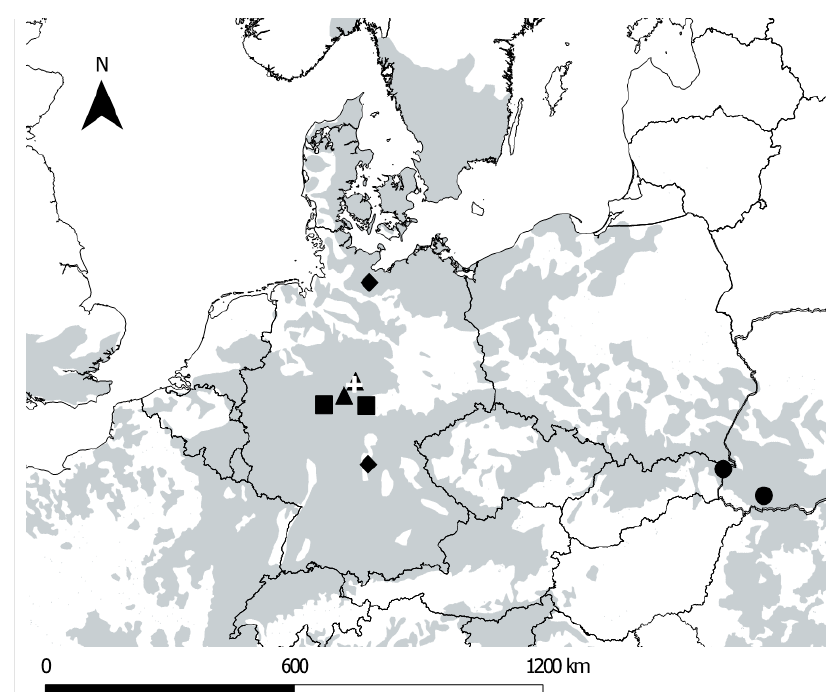
Figure 1. Distribution of Fagus sylvatica L. in Central Europe (grey area) and location of studied beech forests ( ▲ = Traditionally managed, ♦ = Alternatively managed, ■ = National Parks, ● = Primary forests). Source of species distribution map: http://www.euforgen.org. The white + indicates the location of the inventory study site used for the young tree regeneration inventory (Waake, near Göttingen). Table 1. Information on location and basic environmental conditions of the study sites. For each management type, we chose two study sites. For each study site of the management type “Traditional” and “Alternative”, the age classes “0–20”, “ 21 – 40”, “41 – 80”, and “81 – 120” were considered.